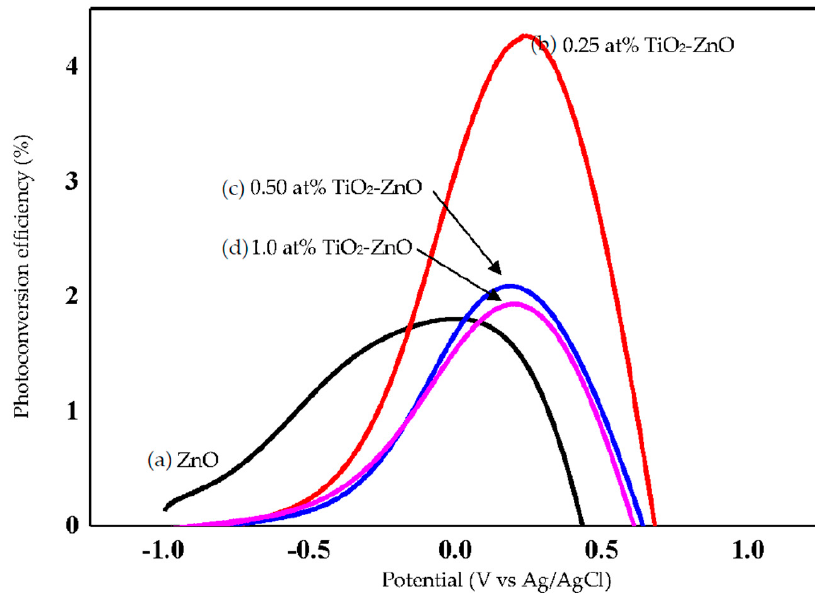
Figure 14. Photoconversion efficiency of ( a ) ZnO; ( b ) 0.25 at % TiO 2 -ZnO; ( c ) 0.50 at % TiO 2 -ZnO; and ( d ) 1.0 at % TiO 2 -ZnO under solar illumination.